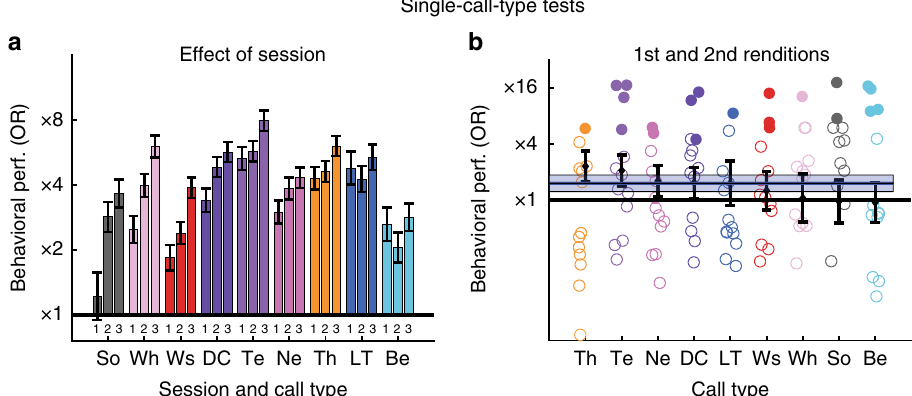
Fig. 5 Behavioral generalization across renditions in single-call-type tests. Effect of gain of experience with the sounds over the course of a daily test on behavioral performance ( n = 13 birds) where discrimination for vocalizer is assessed independently for each call type. a Behavioral tests were divided into three consecutive 30-min sessions labeled 1 − 3 (see Supplementary Methods). The bar plots illustrate the signi fi cant effect of session on bird performances. Call types are ordered along a decreasing effect of session from left to right. OR (odds ratio) increases with session rank for all adult call types but not for chick vocalizations (effect of Session:VocType: LRT on GLME, χ 2 2 = 308.7, p = 0). Despite the behavioral improvement due to session training, the discrimination of vocalizers is above chance level even during the fi rst 30-min session for all call types (effect of VocType on fi rst session data: LRT on two GLME, χ 2 1 = 270.95, p = 0). b The scatter plots show behavioral performances when the dataset is restricted to stimuli constructed with renditions heard once or twice. As in Fig. 4b, colored circles show performance of individual subjects and the black diamonds and error bars show the average performance and 95% con fi dence intervals obtained from the coef fi cients of GLME. Filled (vs. empty) circles indicate that the behavioral performance is signi fi cantly above chance. Birds signi fi cantly discriminate between the vocalizers achieving an average OR value across call types (blue line) with its 95% con fi dence interval (blue box) higher than chance level (effect of VocType on stimulus renditions heard once or twice: LRT on GLME, χ 2 1 = 15.8, p = 7.03×10 -5 ). There is also a signi fi cant interaction of OR with call type (black diamonds): Note that Te, Th, and DC are still among the best